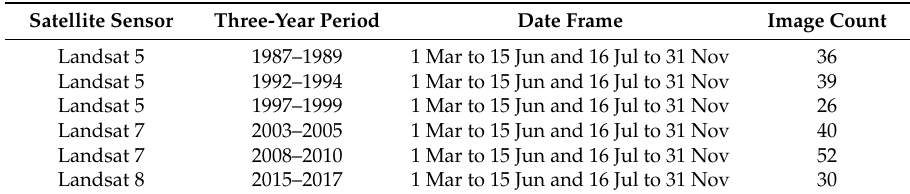
Table 1. The selected image collections for the study